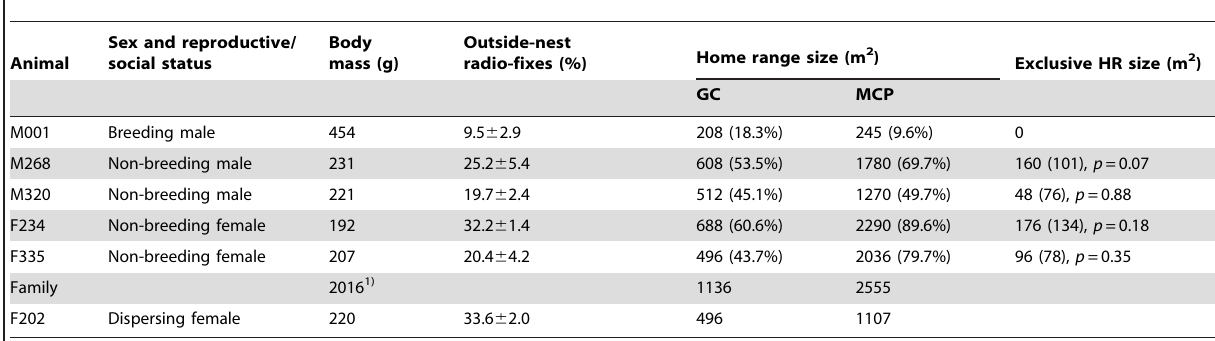
Table 1. Home range sizes and proportions of outside-nest fixes of the radio-tracked mole-rats.